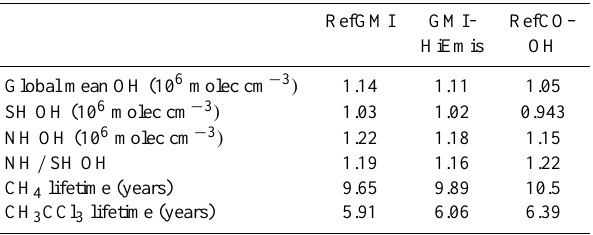
Table 2. Tropospheric OH concentrations and lifetimes against ox- idation by tropospheric